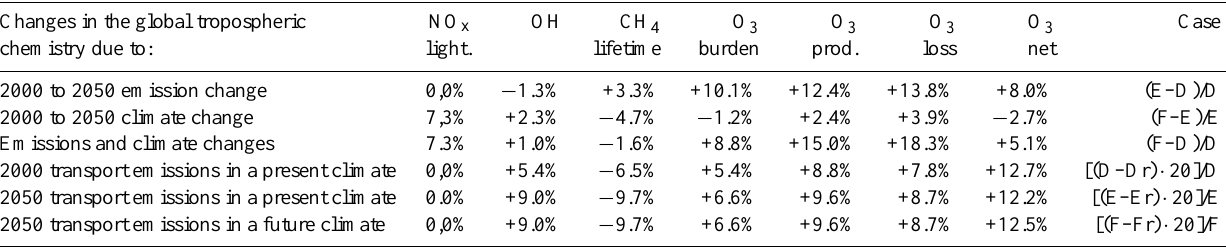
Table 4. Impact of changes in emissions and in climate, on the global tropospheric chemistry. “O 3 prod.”, “O 3 loss” and “O 3 net” refer to the O 3 chemical production, O 3 chemical loss and O 3 chemical net production, respectively. The r subscript letter refers to 5% reduction of transport emissions. See Table 2 for the definition of the D, E and F experiments.